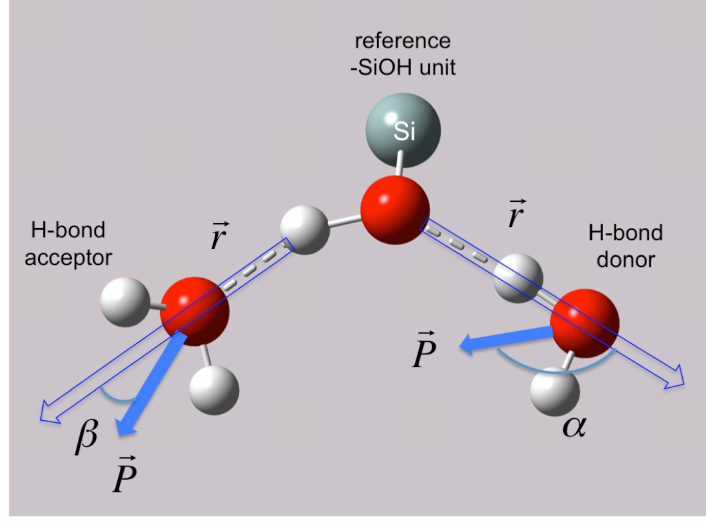
Figure 4. Definition of dipole moment orientation of H water|quartz